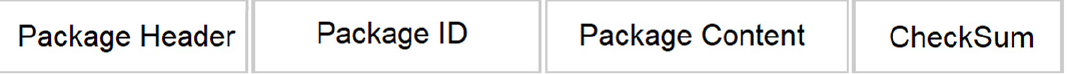
Figure 8. Communication package consists of 4 parts: package header, package ID, package content, and checksum.